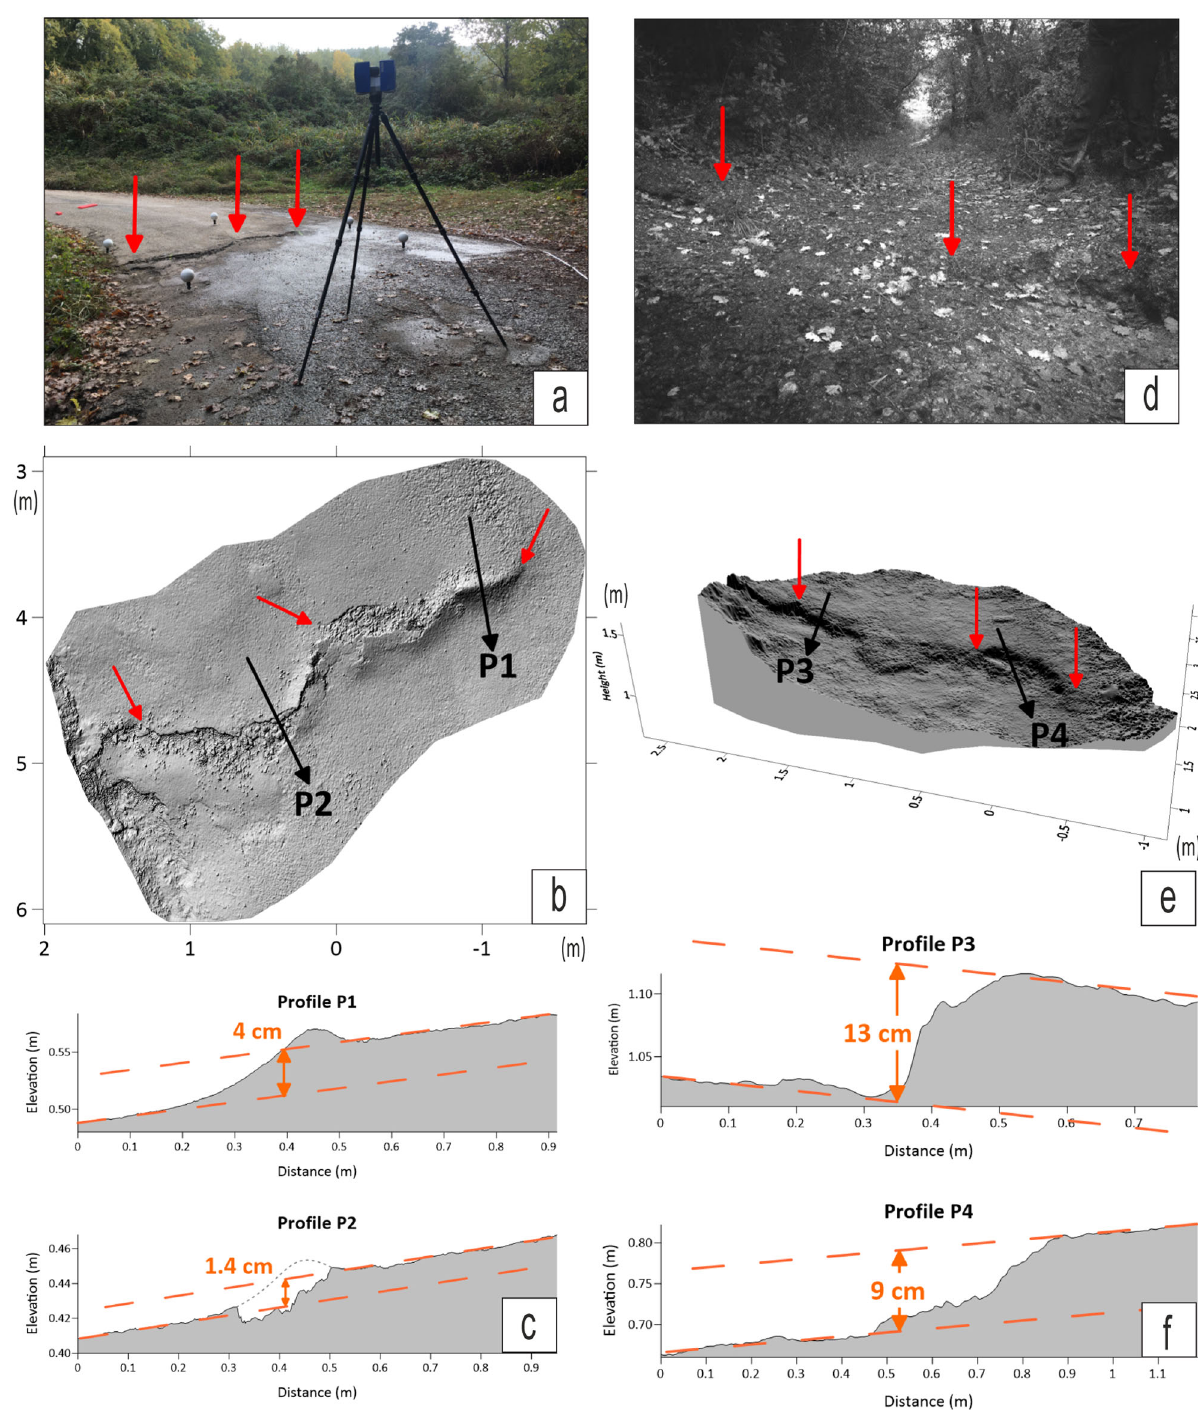
Fig. 6 Examples of surface ruptures and associated deformation measurements. a , d Field photographs showing surface ruptures affecting an asphalt road and a dirt path (evidences #1 and #5, respectively, see location Fig. 4). Red arrows point to the rupture. Equipment visible in a is a laser scanner used in the following. b , e Ultra-high-resolution (1 mm) laser scans at the same locations. Red arrows point to the same locations as in fi eld photographs. c , f Topographic pro fi les extracted from laser scans, showing the vertical